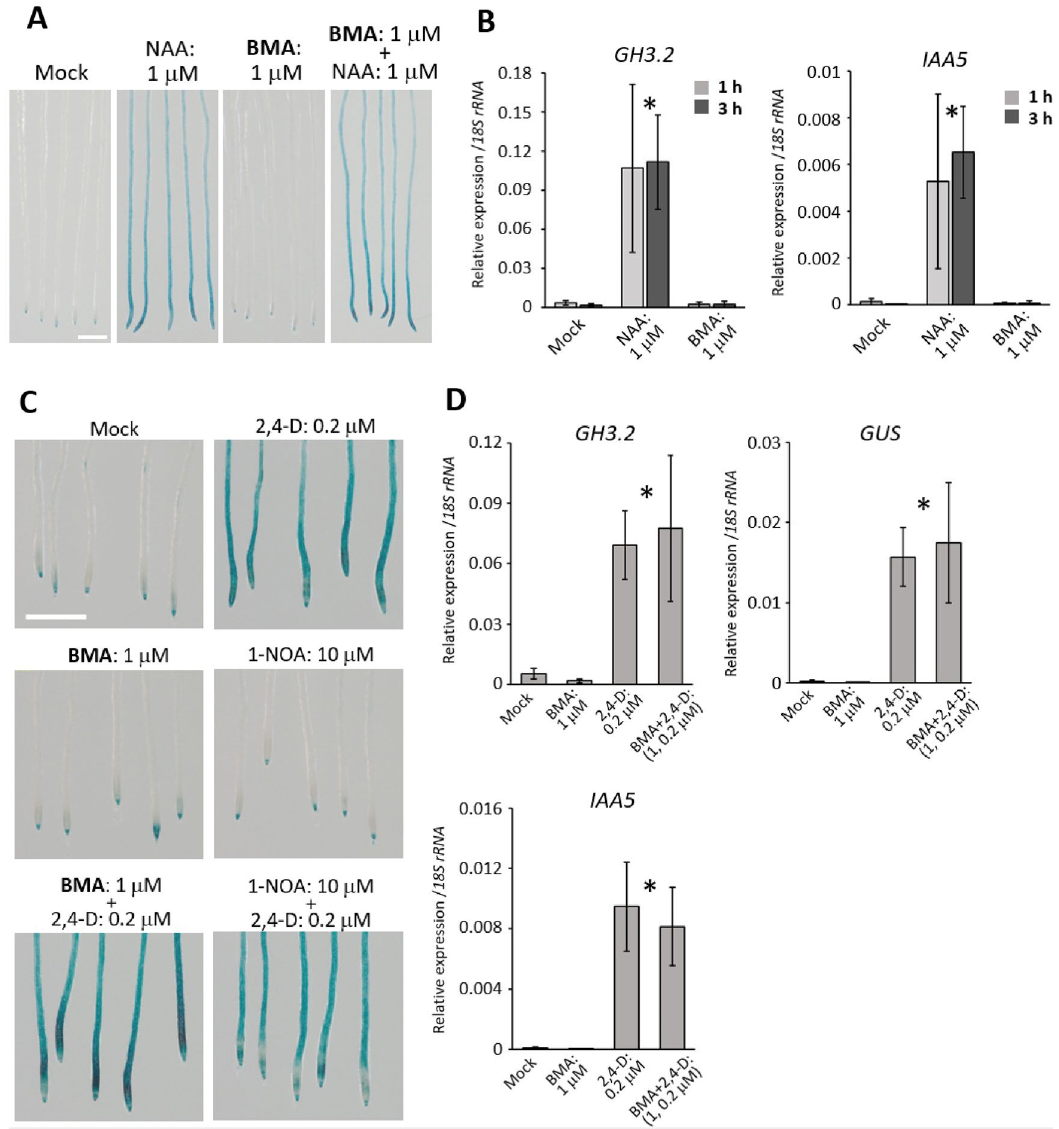
Figure 5. ( A ) Effect of BMA on DR5:GUS expression in Arabidopsis roots. Six-day-old seedlings of Arabidopsis with DR5:GUS plants were incubated for 7 h with 1 μM of BMA with or without 1 μM NAA. Bar = 1 mm. ( B ) The effect of BMA on the expression of the early auxin-inducible genes GH3.2 and IAA5 in roots by qRT- PCR. The expression of indicated genes was quantified after 1 and 3 h after treatment. Error bar indicates S.D. Asterisks indicate no significant differences between samples (Tukey, P < 0.01). n = 4. ( C ) Evaluation of the effect of 1-NOA and BMA on 2,4-D uptake in Arabidopsis roots. Arabidopsis seedlings with DR5:GUS reporter system were preincubated for 1 h with 10 μM 1-NOA or 1 μM BMA. Subsequently, the seedlings were incubated for 7 h with 10 μM 1-NOA or 1 μM BMA, with or without 0.2 μM 2,4-D. Bar = 1 mm. ( D ) The effect of BMA on the expression of GH3.2 , IAA5 and GUS in roots by qRT-PCR. Arabidopsis seedlings with DR5:GUS reporter system were preincubated for 1 h with 1 μM BMA. Subsequently, the seedlings were incubated for 7 h with 1 μM BMA, with or without 0.2 μM 2,4-D. After treatment, the expression of indicated genes was investigated. Error bar indicates S.D. Asterisks indicate no significant differences between samples (Tukey, P < 0.01). n = indicate that BMA affects auxin transport at the root tip and inhibits gravitropism by affecting auxin distribution at the root tip in a manner different from that of NPA. When Arabidopsis seedlings were grown on a vertical agar plate containing BMA, the seedlings showed "wavy" and "curly " root phenotypes, which were not observed when grown in the presence of NPA. Arabidopsis roots elongated linearly in the presence of NPA (Fig. 6). In root hair formation, NPA promoted the formation of excessive root hairs, whereas BMA did not cause excessive root hair formation as NPA did (Fig. S3A and B). The effects of NPA and BMA were further compared using etiolated seedlings (Fig. S3C–E). Both NPA and BMA significantly inhibited hypocotyl elongation (Fig. S3D). On the other hand, NPA significantly affected the direction of hypocotyl elongation, while BMA did not (Fig. S3E). These results indicate that BMA is a